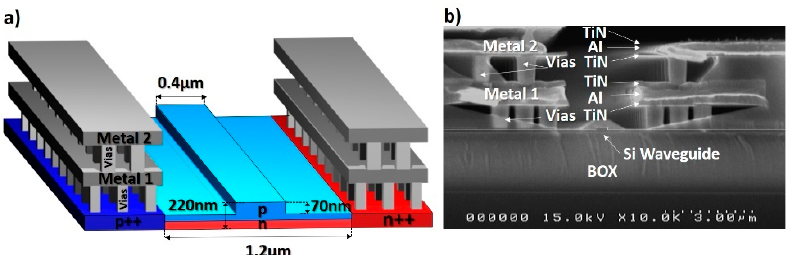
Figure 15. ( a ) A sketch of the silicon E/O modulator embedded in a vertical pn junction. ( b ) SEM cross-section of the Si modulator after HF wet-etch showing the 2-layer metal stack (M1:W vias /Ti/TiN/Al/TiN, M2: W vias /TiN/Al/TiN).